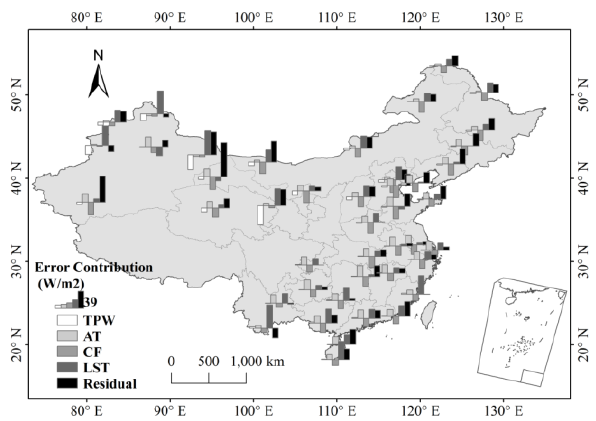
Figure 6. Main sources of net radiation error for CERES